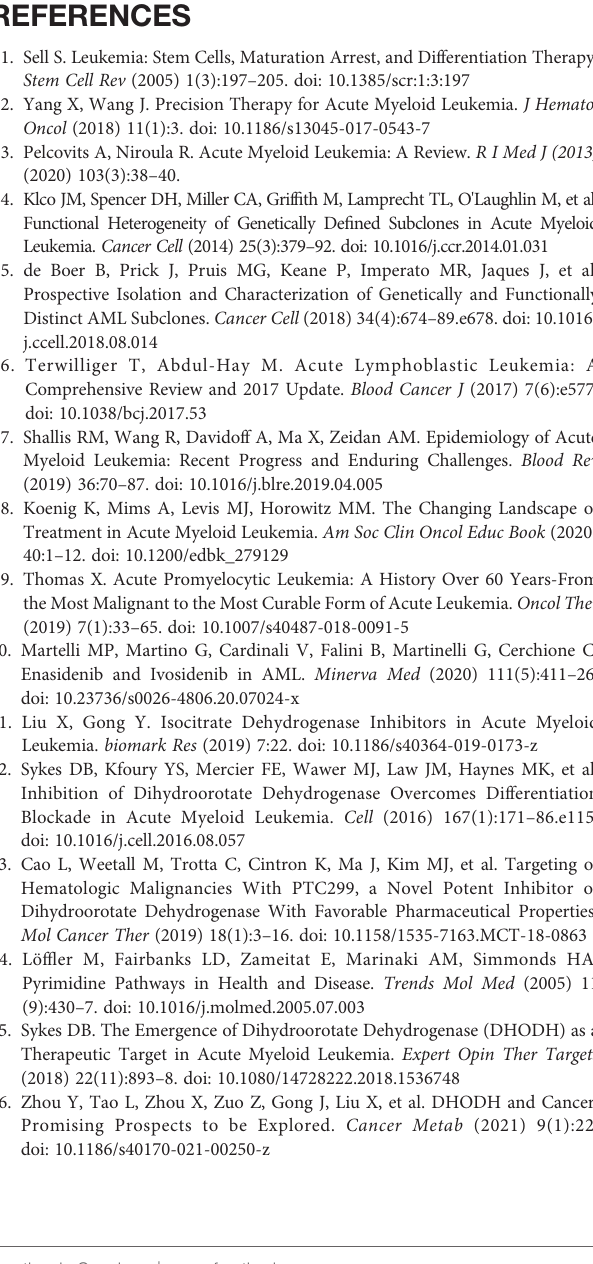
Supplementary Figure 3 | Primary AML blasts cultured ex vivo were treated with increasing concentrations of emvododstat. Blasts cells were identi fi ed and further de fi ned as differentiated (CD14+) or undifferentiated. Supplementary Figure 4 | Uridine reverses emvododstat-mediated effects ontotal blast counts in primary AML blasts and on AML cell lines. (A) total blasts cellsfrom sample AML293, addition of ≥ 30 m M of uridine reversal of the effect ofemvododstat on reduction in total blasts; (B) total blasts cells from sample AML299,addition of ≥ 30 µM of uridine reduces the effect of emvododstat on reduction in totalblasts, with complete reversal at 100 µM. (B) AML303 does not respond toemvododstat. (C) Uridine rescue has no effect on doxorubicin-induced cytotoxicity of MOLM-13. (D) Uridine has no effect on viability of blocksMOLM13